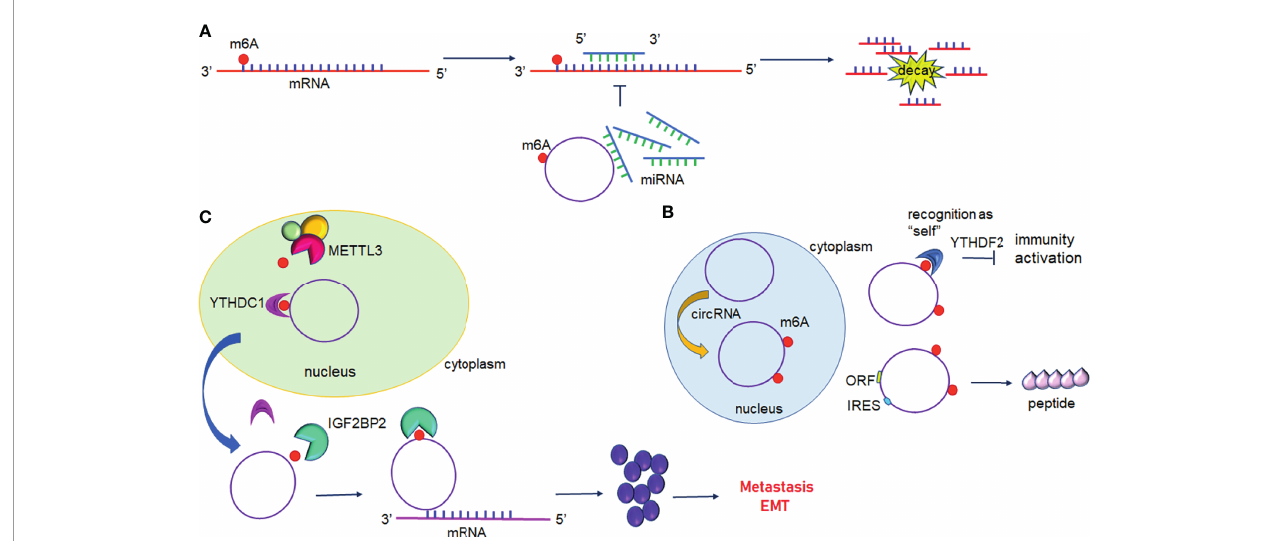
FIGURE 4 | Interplay between circular RNAs and m6A modi fi cation. (A) circRNAs act as ceRNA to regulate gene expression. m6A modi fi ed circRNAs sequester miRNAs resulting in inhibition of miRNA-direct gene silencing. (B) m6A modi fi cation of circRNAs suppresses immune genes expression or initiates translation. (C) m6A modi fi ed circRNAs regulate gene expression by directly targeting mRNA.YTHDC1 promotes the nuclear export of circRNAs to the cytoplasm following methylation by METTL3. IGF2BP2 promotes the stability of m6A-circRNAs and interacts with oncogenic mRNAs.